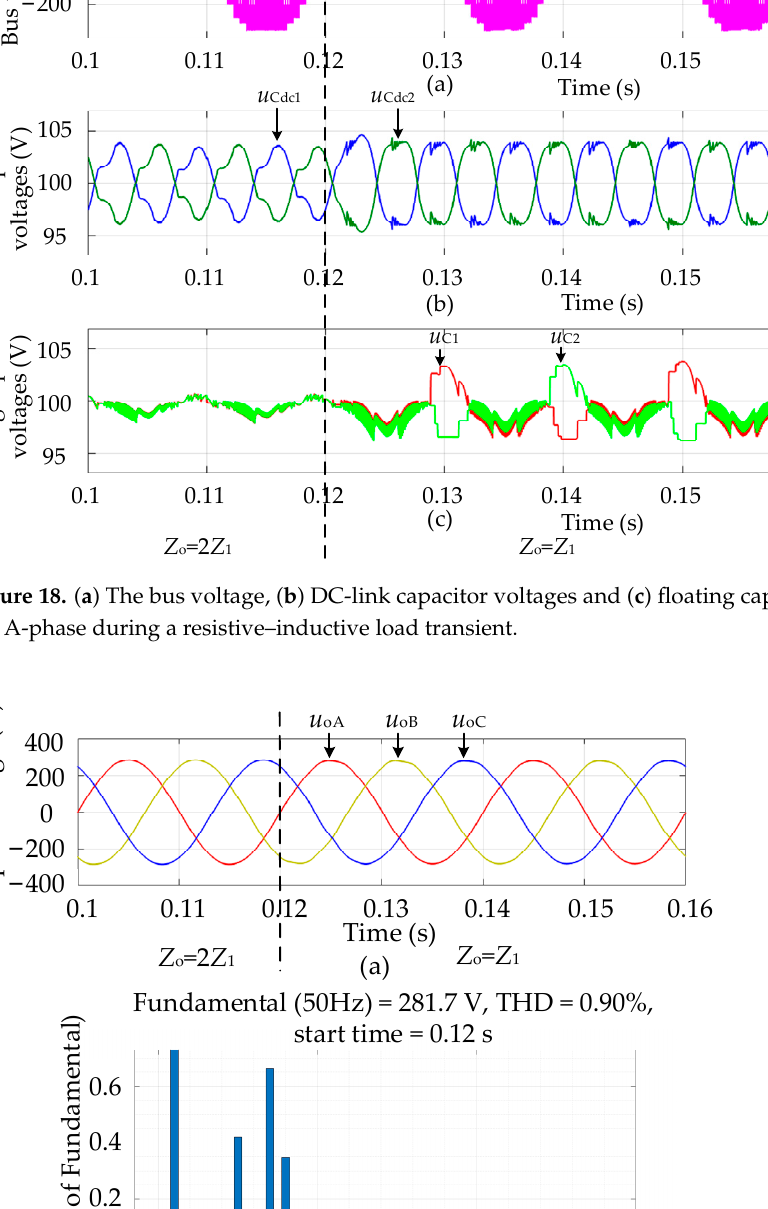
Figure 18. ( a ) The bus voltage, ( b ) DC-link capacitor voltages and ( c ) floating capacitor voltages of the A-phase during a resistive–inductive load transient.